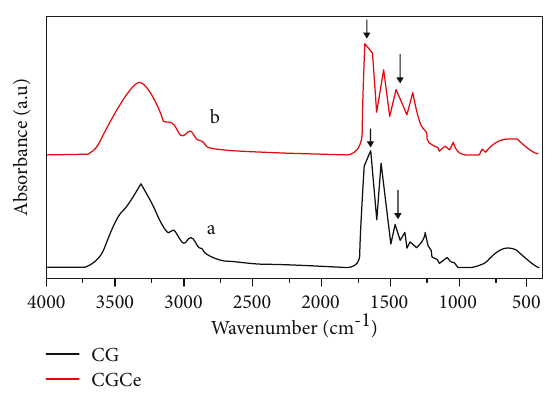
Figure 1: FTIR spectra of CG and CGCe.